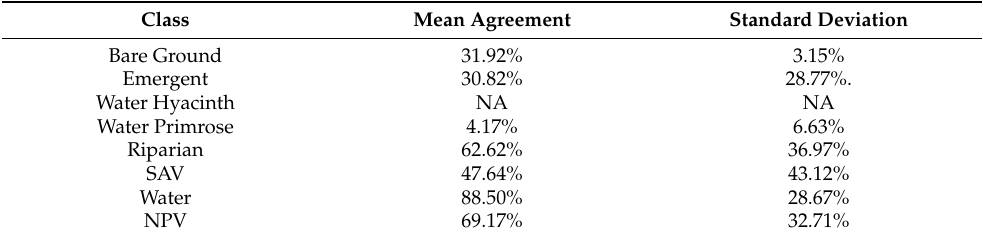
Figure 8. Classified HyMap map, and frequency maps showing regions of Nano pixels within a HyMap pixel and their level of agreement with the HyMap class. Note: water hyacinth was omitted because HyMap found none in the study region. Table 5. Mean agreement and standard deviation between HyMap pixel and Nano pixels contained within by class.